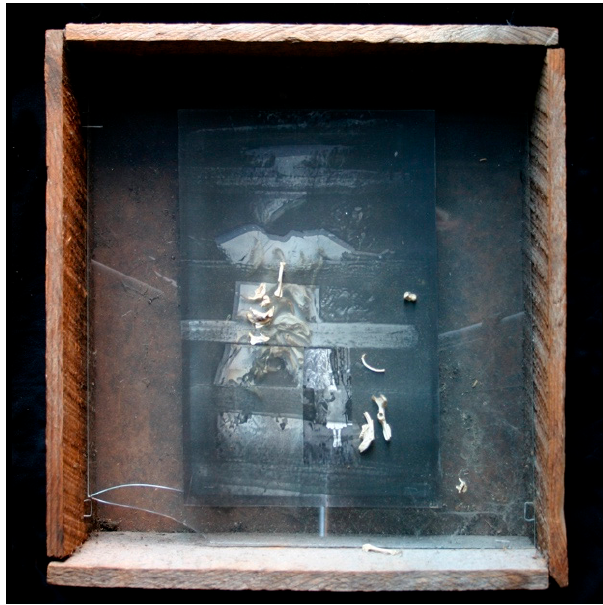
Figure 2. Woman in White (1980). Found box, dust, photos, spider webs, and mouse bones.